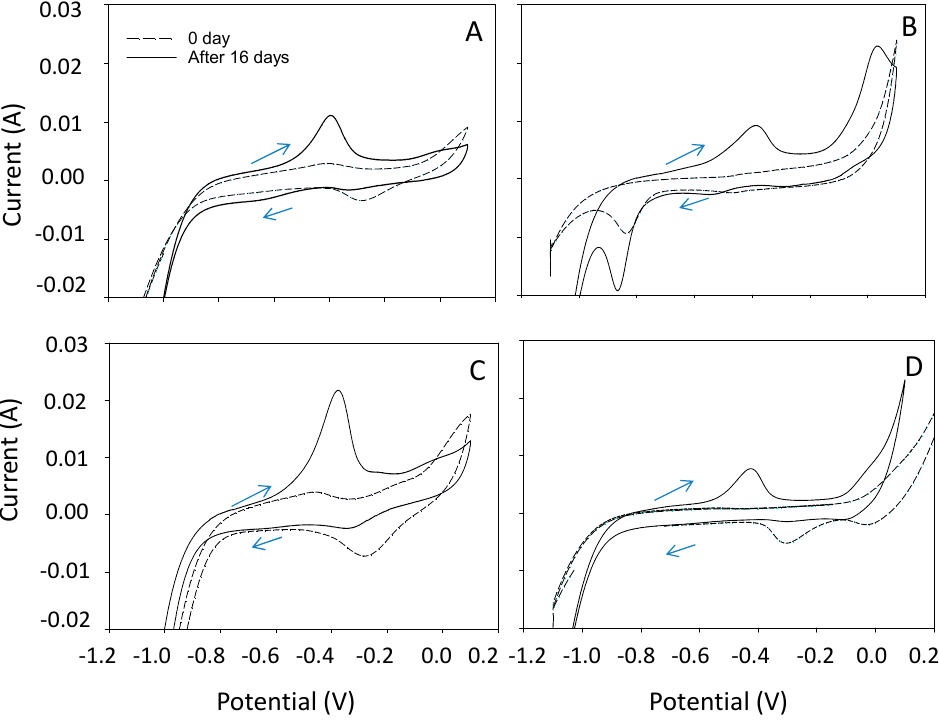
Figure 5. Cyclic voltammetry analysis with different redox mediators. ( A ) Control, ( B ) NR, ( C ) HNQ, ( D ) HQ. The dotted line indicates the initial cyclic voltammetry (CV) analysis before the cycles, and the solid line is CV analysis after the eighth cycle. Electrode area: 4 cm × 5 cm carbon felt. The scan range was between − 1.11 and +0.1 V (vs. Ag/AgCl 3M KCl), and the scan rate was 10 mV/s.